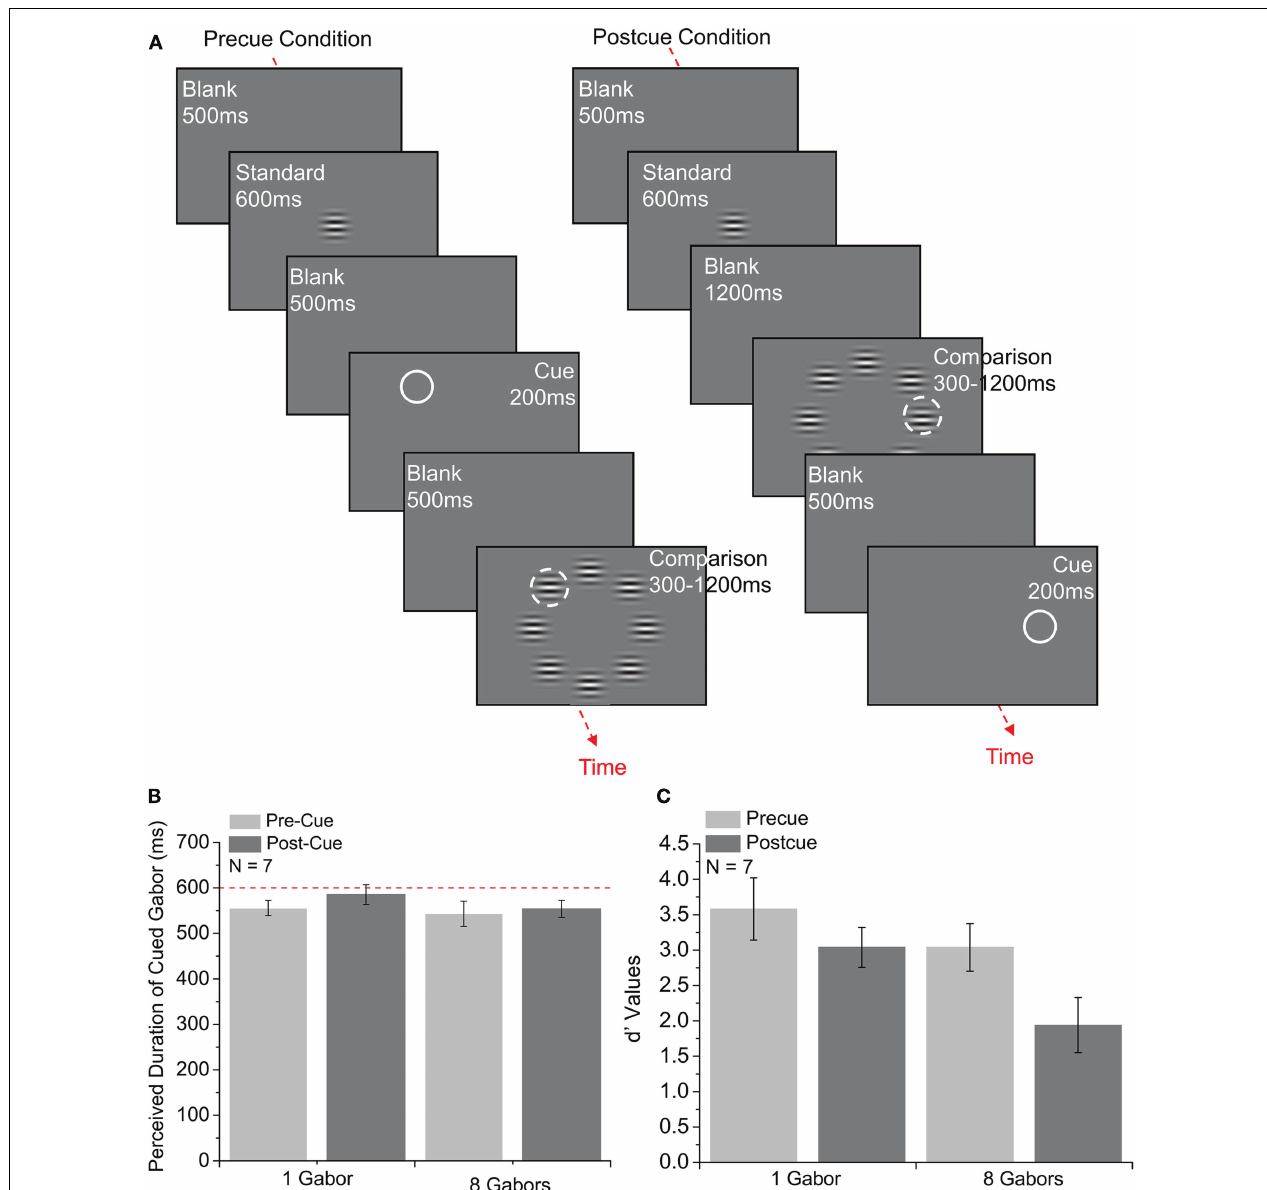
Mean perceived durations of cued Gabor for seven subjects are plotted as a function of the number of Gabor stimuli on the comparison array.The dashed line indicates the duration of the standard Gabor. Error bars show ± 1 SE of the mean. Each point is derived from 210 to 350 trials. (C) Mean d (cid:48) values are plotted in the conditions shown in (B) . Error bars show ± 1 SE of the mean. Each point is derived from 210 to 350